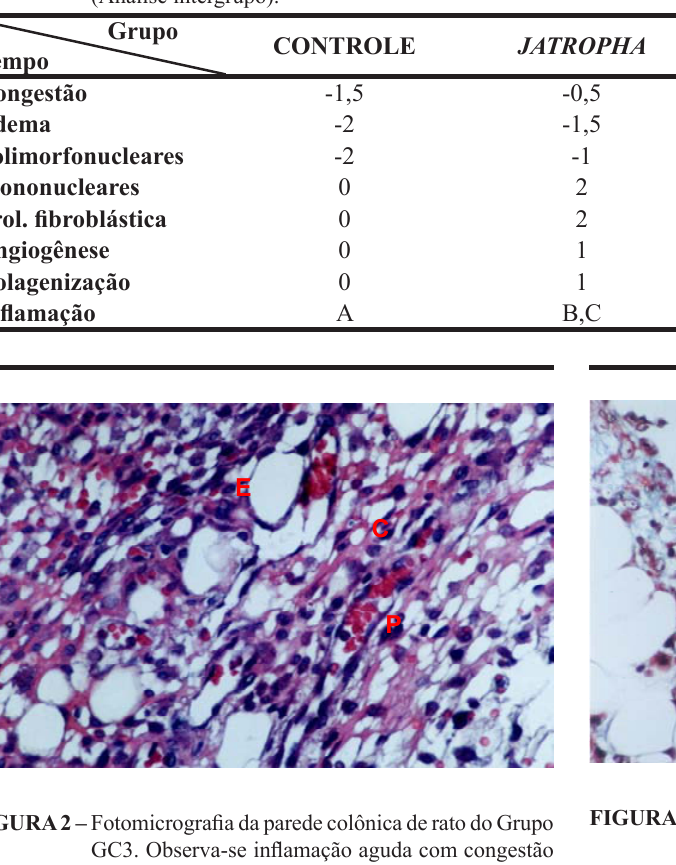
FIGURA 2 – Fotomicrografia da parede colônica de rato do Grupo GC3. Observa-se inflamação aguda com congestão (C), edema (E) e polimorfonucleares (P).Coloração HE 400X.